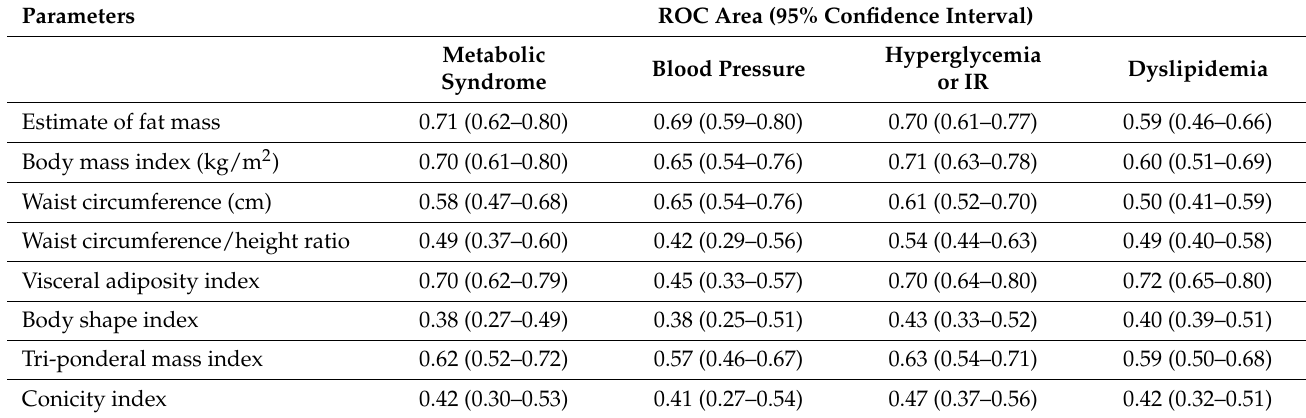
Table 4. Area under curve using ROC analysis for all adiposity